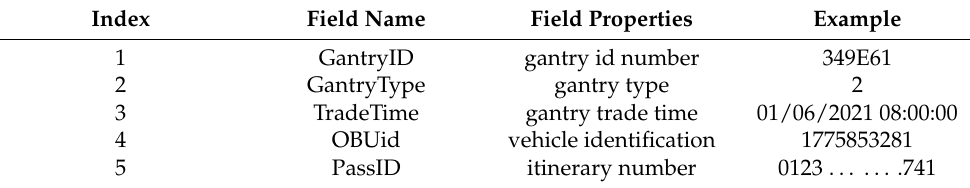
Figure 5. Visualization of ETC gantry deployment in a province. Table 1. Description of Partial Attributes in ETC Transaction